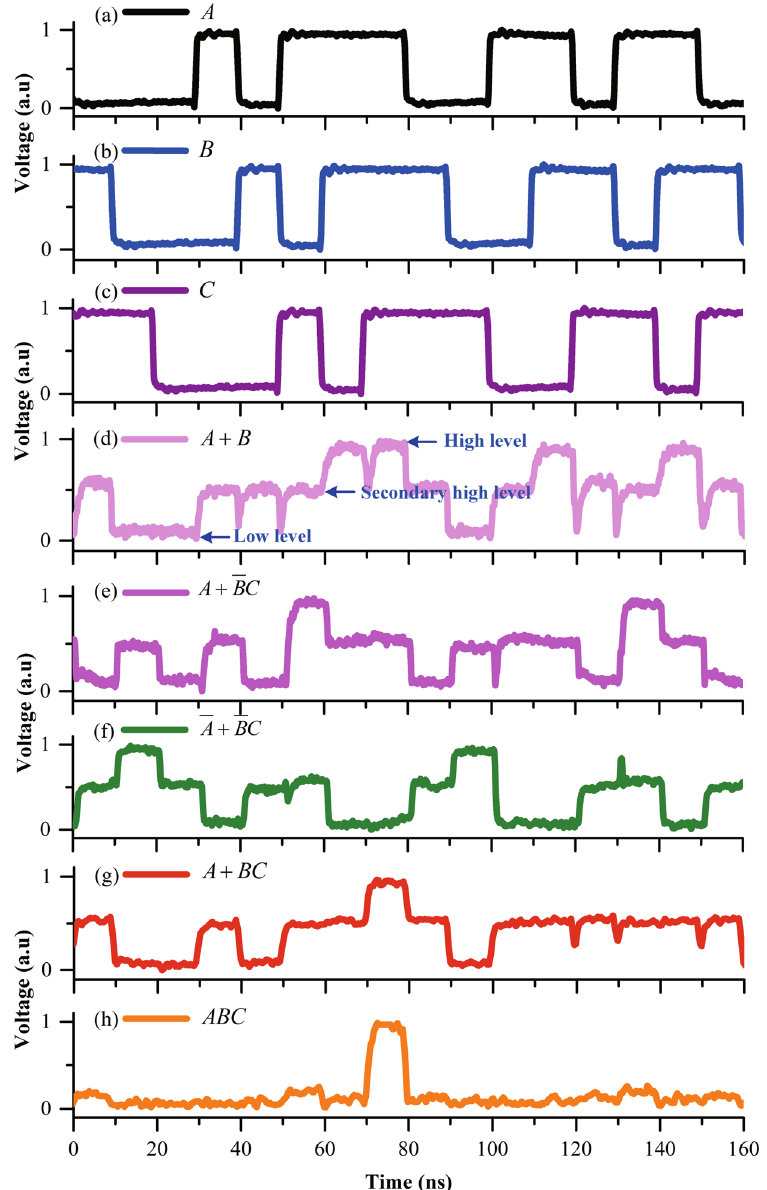
Figure 7. Logic operation results of the device with three-operand (( a – c ) represent the operands applied to MRRs, and ( d – h ) represent the logic operation